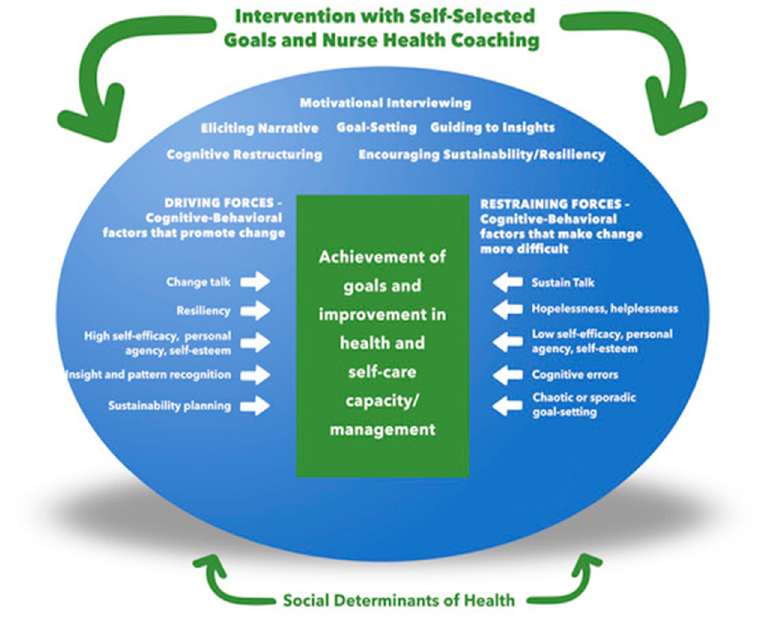
Figure 1. The Nurse Health Coaching (NHC) Framework *. * Adapted from Kurt Lewin’s Force Field Analysis Model.